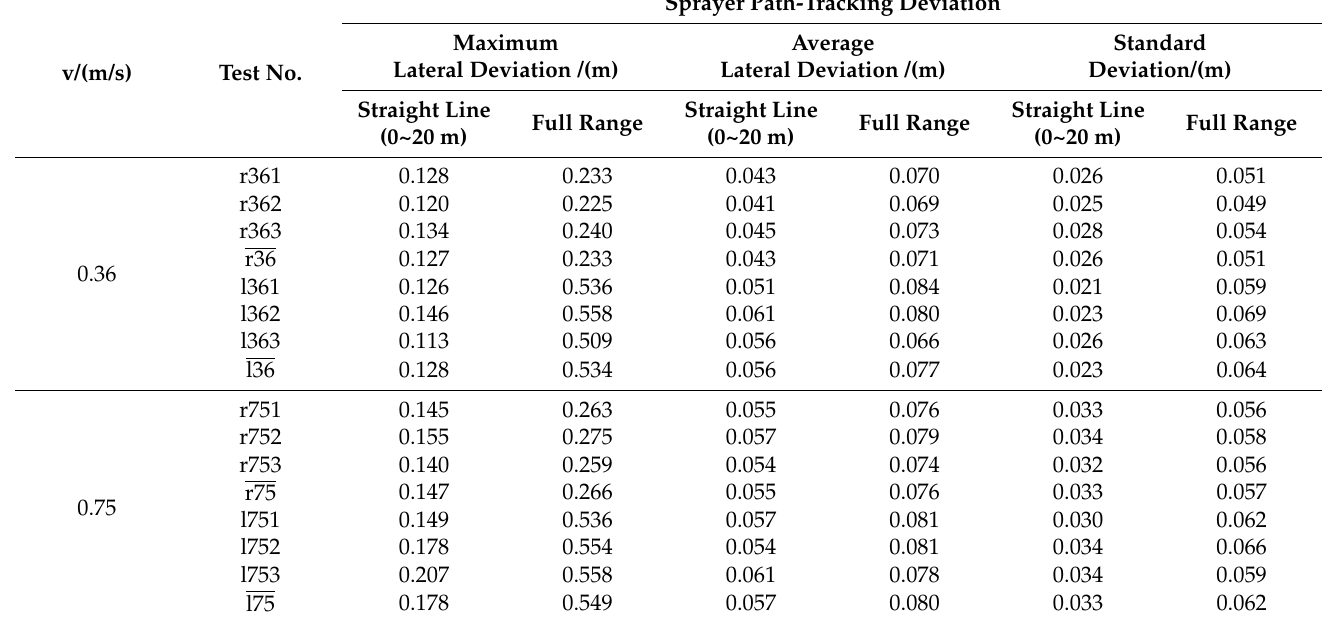
( d ) The 0.75 m/s spraying trailer path-tracking lateral and heading deviations. Figure 18. Results of the real vehicle experiment. Table 5. Path-tracking experimental